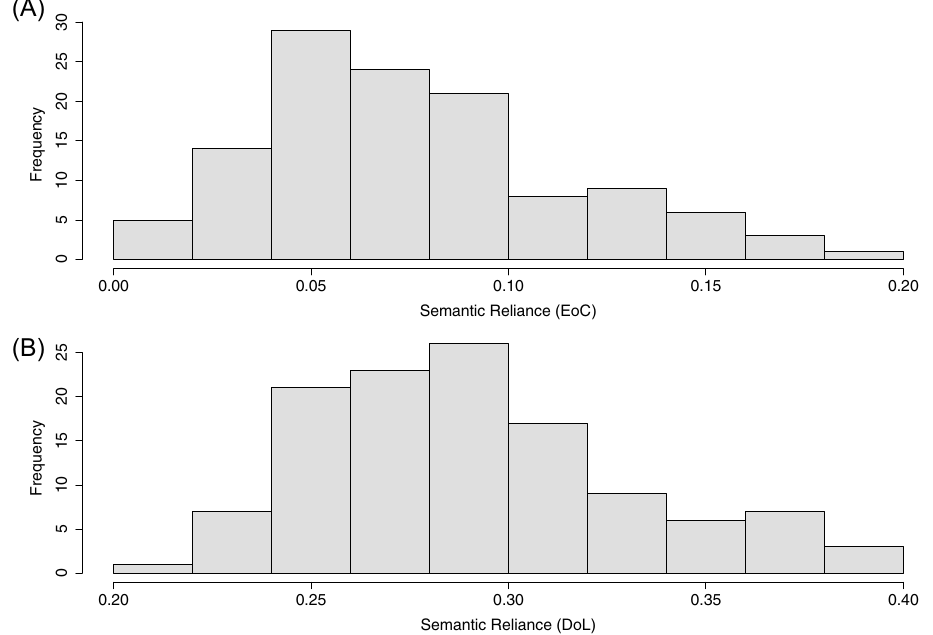
Figure 2. The distribution of semantic reliance based on the effect of consistency (EoC) approach ( A ). The distribution of semantic reliance based on the division of labour (DoL) approach ( B